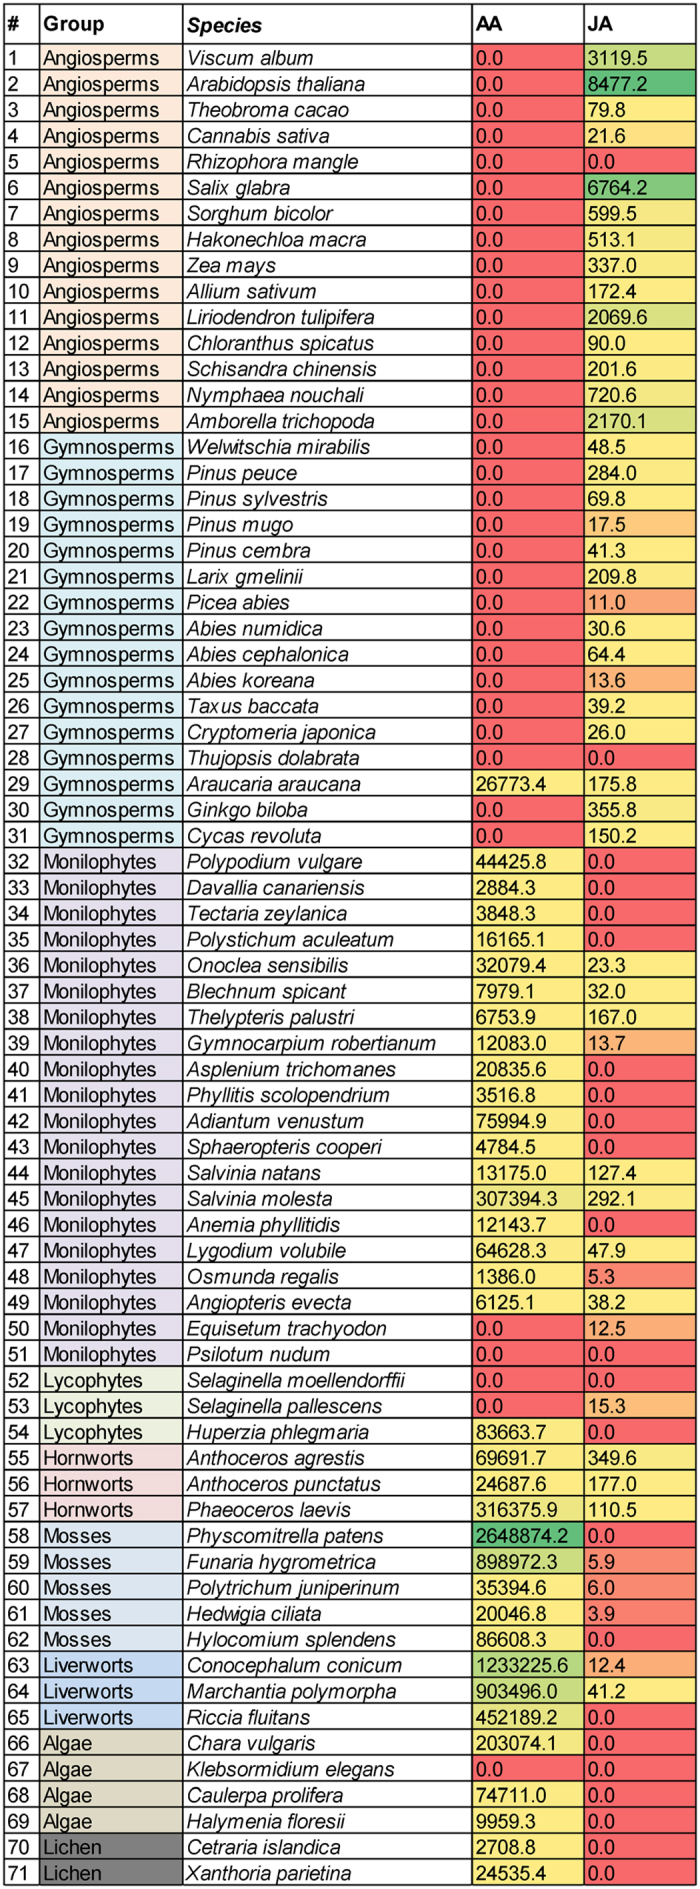
Concentrations (mean values) of AA and JA in pmol/g plant weight found in the 71 plant species analyzed (0.0 = < LOD).The background colors of the cells are used to highlight concentrations in the column (i.e. concentrations of the respective analyte are coded red for small amounts, yellow for intermediate amounts and green for high amounts). Complete information is available in Supplementary Tables S1 and S11.